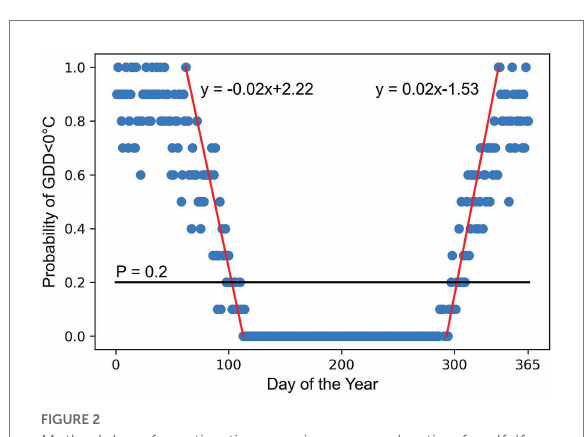
FIGURE 2 Methodology for estimating growing season duration for alfalfa using Noble County, Indiana, as an example. Solid black line represents 0.2 probability of occurrence of growing degree days (GDD) < 0 ° C using a base temperature of 5 ° C for each day of the year for the last 10 years. Solid red lines are the linear regression for decreasing (spring) and increasing (fall) probabilities of days where no GDD were